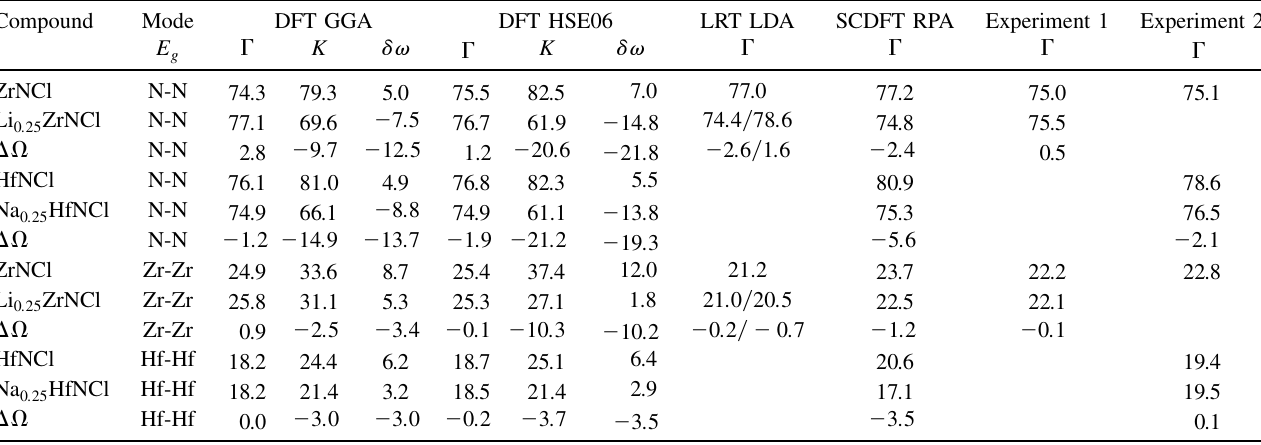
TABLE IV. Phonon frequencies of the E mode at the zone-center (cid:2) point and the zone-boundary K point in the parent ZrNCl and g ZrNCl and Na HfNCl compounds, calculated by frozen-phonon calculations in the HfNCl compounds and electron-doped Li 0 : 25 0 : 25 DFT GGA and DFT HSE06 framework. For comparison, the corresponding phonon frequencies from the LRT LDA calculation in Ref. [14], the SCDFT RPA calculations in Ref. [15], as well as from two experimental measurements (experiment 1 from Ref. [78] and experiment 2 from Ref. [79]), are also displayed. For electron doping, two Li = Na atoms are placed at (0, 0, 0) and (0.5, 0.5, 0) in the mode near the K point upon electron 2 (cid:5) 2 (cid:5) 1 supercell of the original unit cell. Notice the strong phonon softening of the N-N E g doping. This phonon softening is strongly enhanced in the DFT HSE06